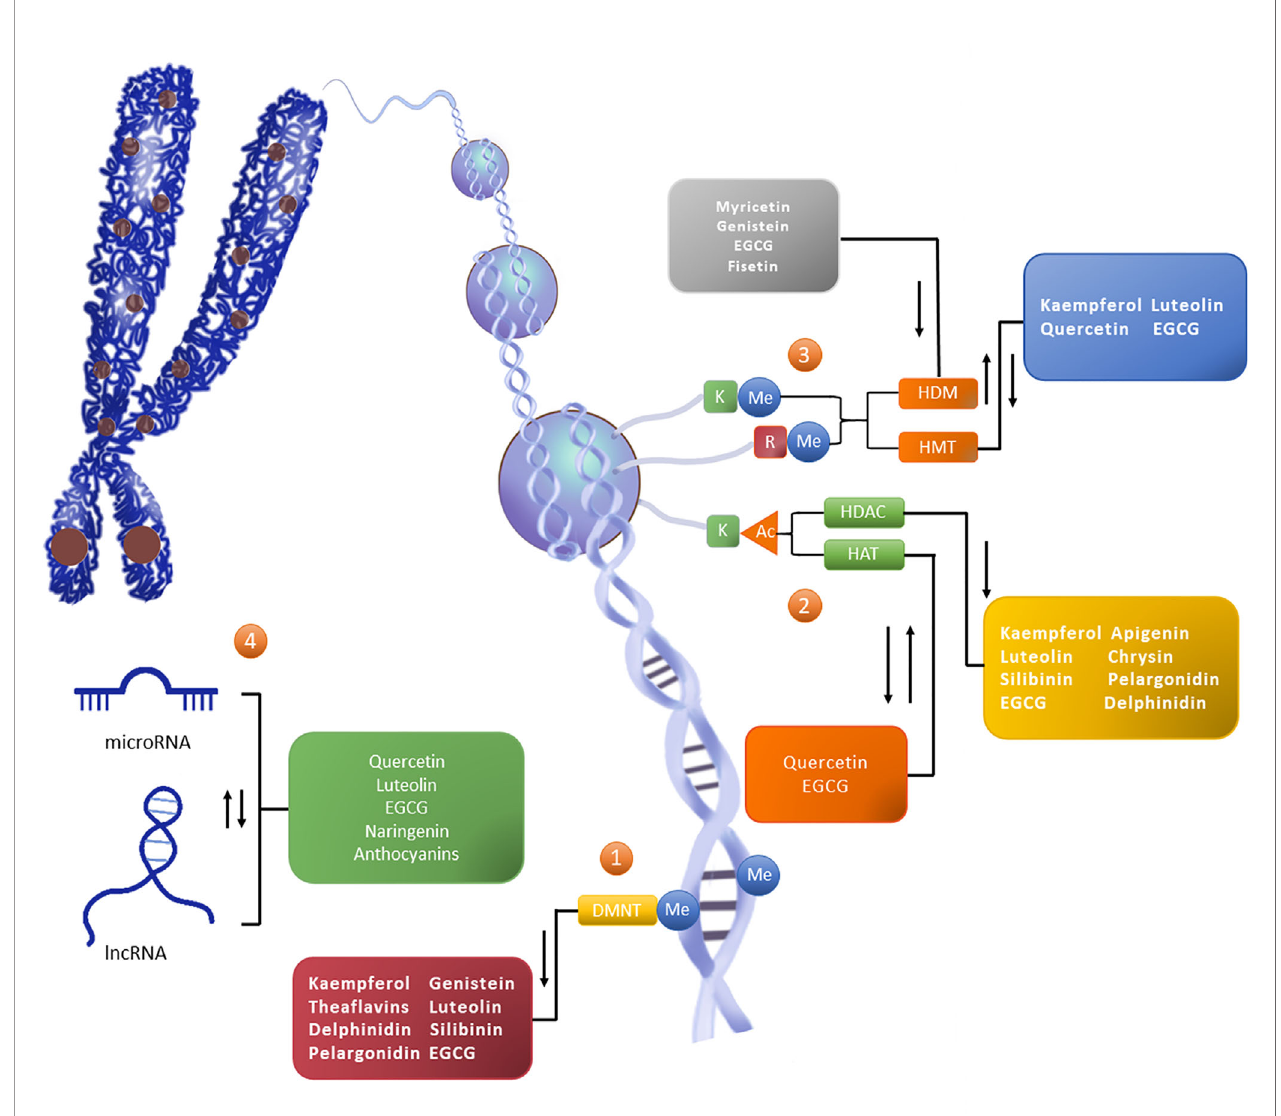
FIGURE 1 | Flavonoids reshape the epigenetic landscape of cancer. Flavonoids exert epigenetic anticancer activity by regulating the level of DNA methylation, histone modi fi cation, and the expression of noncoding RNA. The addition of epigenetic markers depends on writers (such as DNMT, HMT, and HAT), except for erasers (such as HDAC and HDM) which depend on readers (not marked in the fi gure). ① The level of CpG island methylation (Me) in the promoter region of the target gene is increased under the catalysis of DNMT, thus downregulating the activity of the gene. ② Histone modi fi cation occurs on lysine (K) and arginine (R) residues in the histone tail, in which K is the site of histone acetylation (Ac) modi fi cation. HAT promotes gene expression, while HDAC can reduce the level of histone acetylation to reduce gene activity. ③ Histone methylation can occur in K and R. HMT and HDM catalyze epigenetic regulation, and their effects on gene activity vary with amino acid sites and methylation patterns. ④ Noncoding RNAs are also an important part of epigenetic networks. Noncoding RNAs, represented by miRNA and lncRNA, can interact with DNA, mRNA, and proteins, and participate in gene expression processes such as chromosome modi fi cation, transcriptional